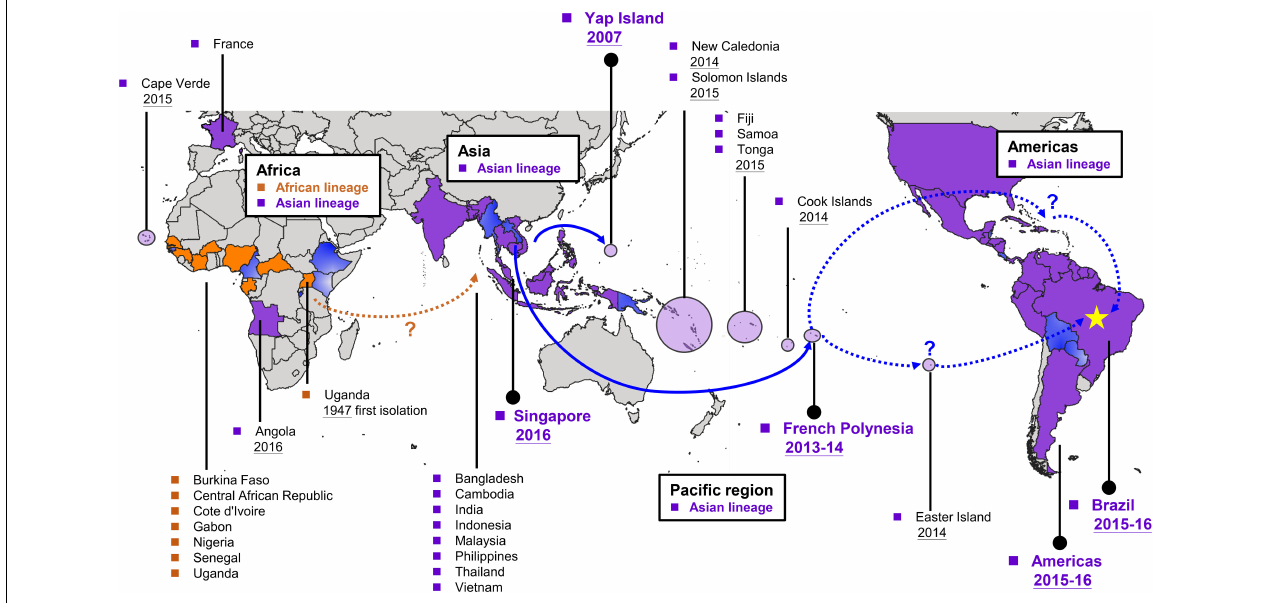
FIGURE 1 | Global dissemination of Zika virus (ZIKV). ZIKV originated from Africa and was then introduced to Asia. Thereafter, ZIKV continuously evolved in Asia and began to cause outbreaks in the Pacific region from 2007. The 2013–2014 French Polynesia strain became the common ancestor worldwide and resulted in recent ZIKV outbreaks in the Americas. According to phylogenetic analysis, the African lineage viruses were circulated mainly in African countries, whereas those circulated in Asia, the Pacific regions, and the Americas were Asian lineage viruses. Countries or areas that have locally acquired ZIKV cases are colored with orange (African lineage circulation), purple (Asian lineage circulation), or gradient blue (the circulating lineage has not been confirmed).